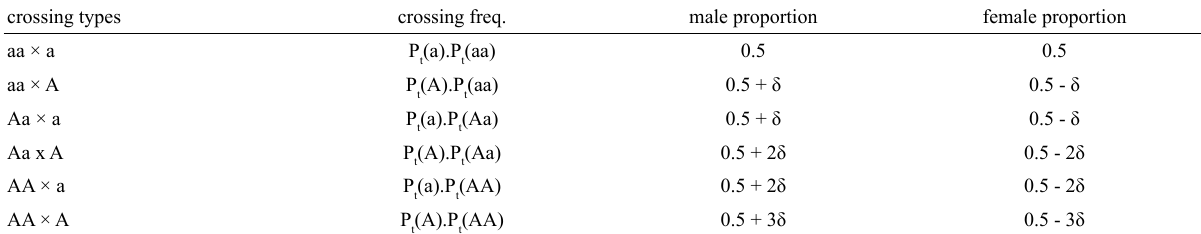
Table 3 ‒ Population frequencies of crossing types and progeny sex proportions. A is an X-linked mutant allele responsible for a distortion in the sex-ratio depending on the number of copies present in the parental pair. It is assumed that the (A, a) locus is active in both X chromosomes among females (model 5). crossing types crossing